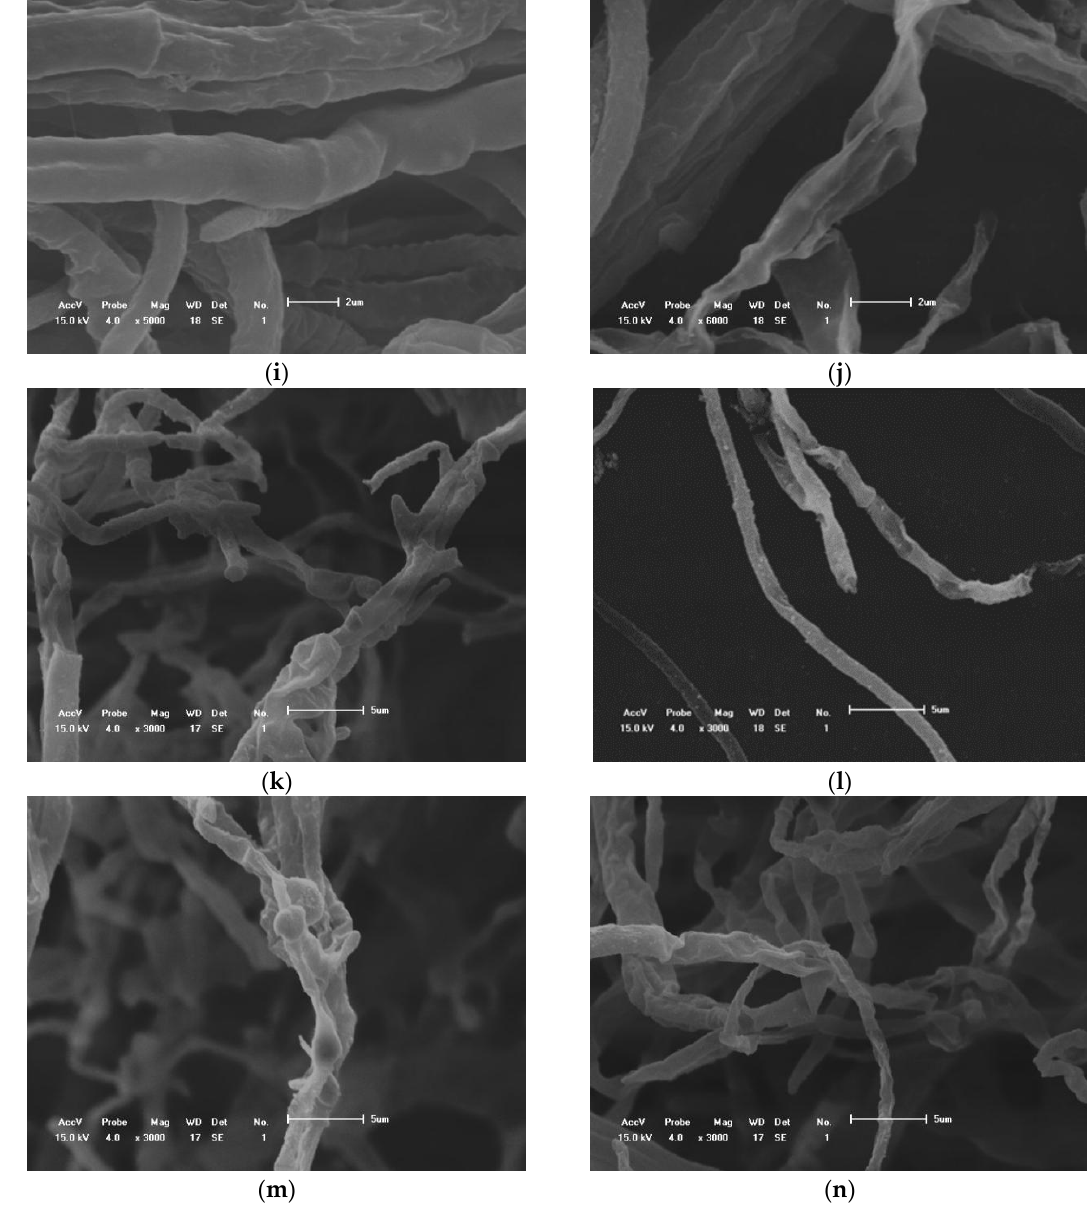
Figure 2. Scanning electron microscopy of the hyphae exposed to three essential oils; ( a – c ) : controls; ( d – f ): A. annua ; ( g – i ): A. lavandulaefolia ; ( j – n ): A. scoparia